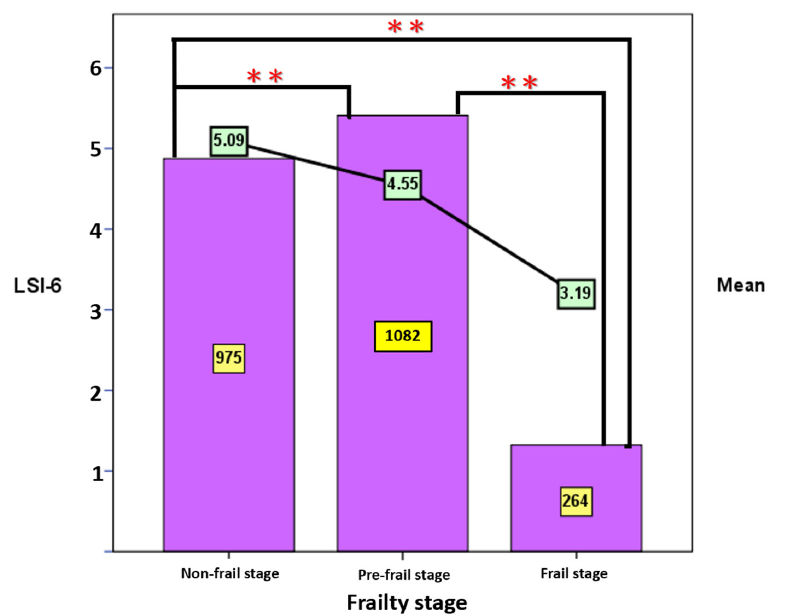
Figure 2. LSI-SF vs. Frailty status. Legend: Non-frailty ( n = 975), Pre-frailty ( n = 1082), Frailty ( n = 264); LSI-SF decreased with increasing frailty status. ** p < 0.01